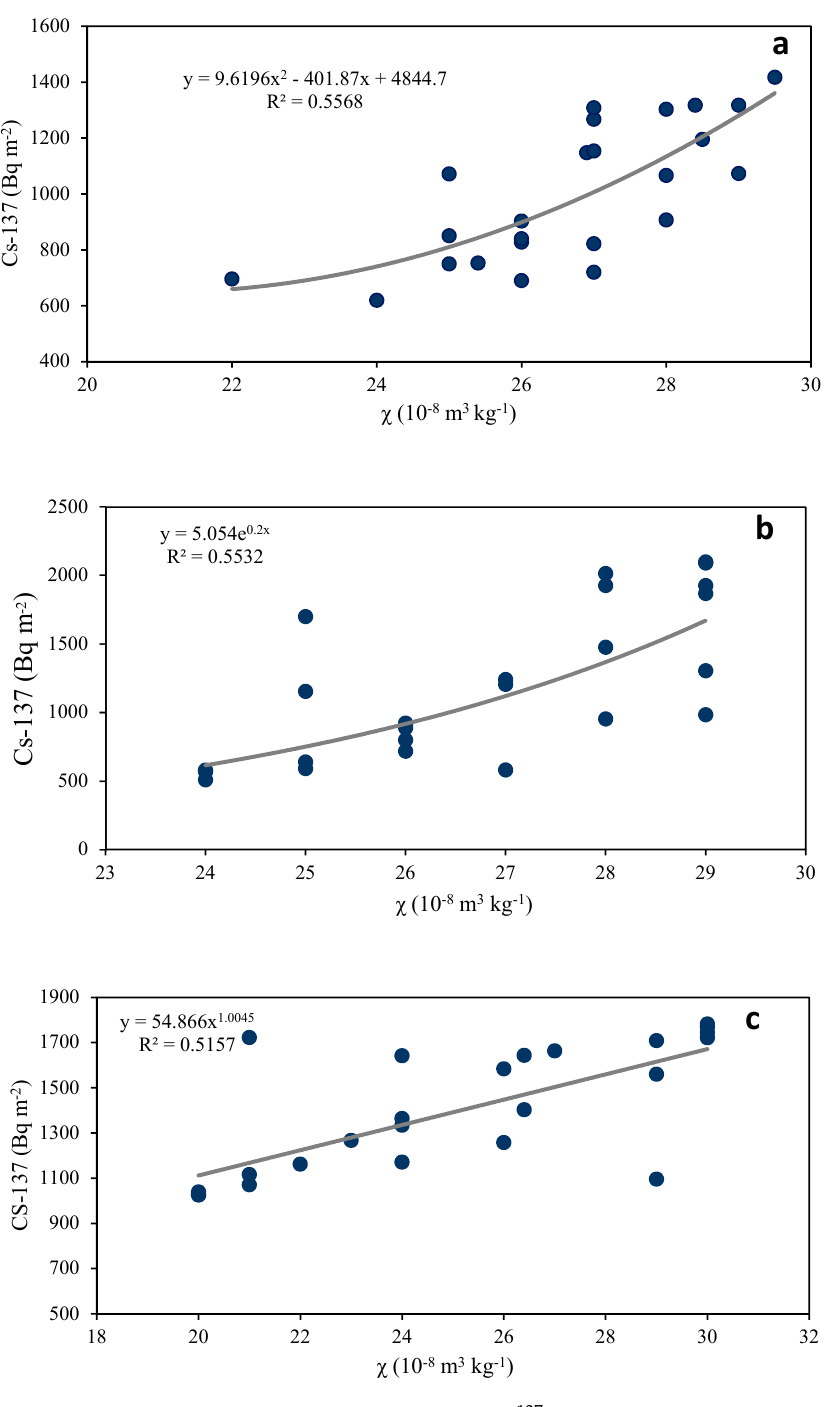
Figure 6. Non-linear relationships between χ lf and 137 Cs inventory in three land uses: ( a ) apple orchard; ( b ) dryland; ( c ) rangeland.